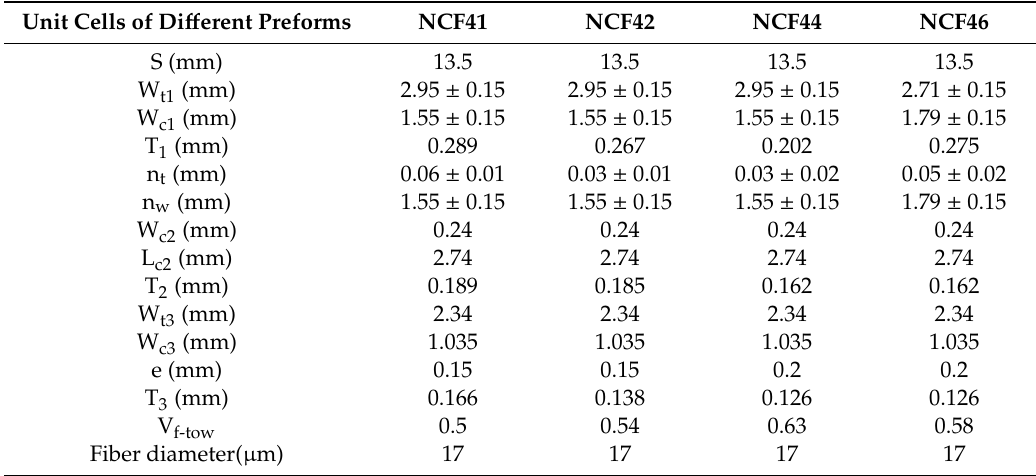
Table 6. Input parameters for generating unit cell models for each